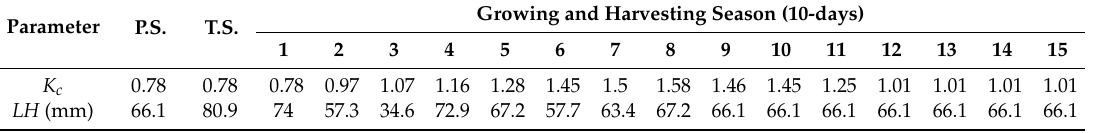
Table 1. Seasonal crop coe ffi cients and outlet heights of paddy fields in Korea [8,32]. Parameter P.S.